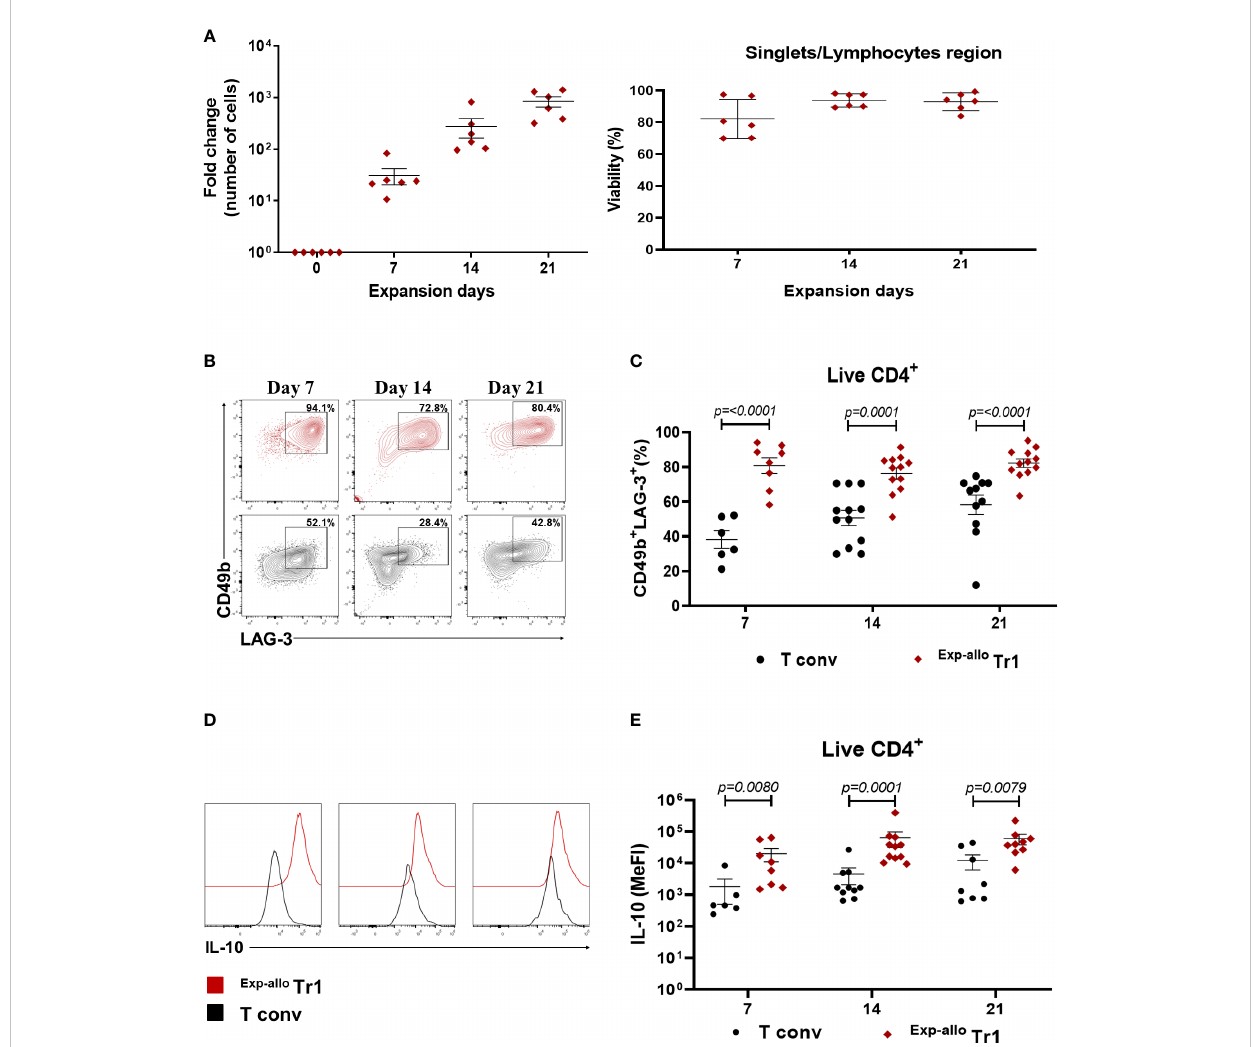
FIGURE 3 Puri fi ed Allo Tr1 cells can be long-term expanded, conserving their CD49b + LAG3 + phenotype and IL-10 production. FACS-sorter Allo Tr1 cells or T conv were polyclonally-expanded for 21 days in the presence of IL-10 plus IL-2 or only IL-2, respectively. (A) Left, A llo Tr1 cell proliferation reaching an average fold increase of 840 times at day 21 of stimulation (n= 6). Fold expansion was calculated by dividing the number of Tr1 cells obtained on the evaluated day by the number of Tr1 cells on day 1 of FACS-sorting. Right, viability of Exp-allo Tr1. Data are representative of four independent experiments. (B) Representative contour-plot of LAG-3 and CD49b co-expression in Exp-allo Tr1 cells (red) and T conv (black) at each cycle of in vitro expansion. (C) Proportion of CD49b + LAG-3 + in Exp-allo Tr1 cells (red, n= 6-12) compared to T conv (black, n= 6-12). (D) Representative histograms of IL-10 production in Exp-allo Tr1 cells and T conv. (E) Median Fluorescence Intensity (MeFI) of IL-10 in Exp-allo Tr1 cells (red) compared with T conv (black) throughout the expansion. All experiments were performed in duplicates. Data are representative of six independent experiments. The results are shown as mean ± SEM. The statistical analysis were performed using the unpaired-t test or the Mann – Whitney U